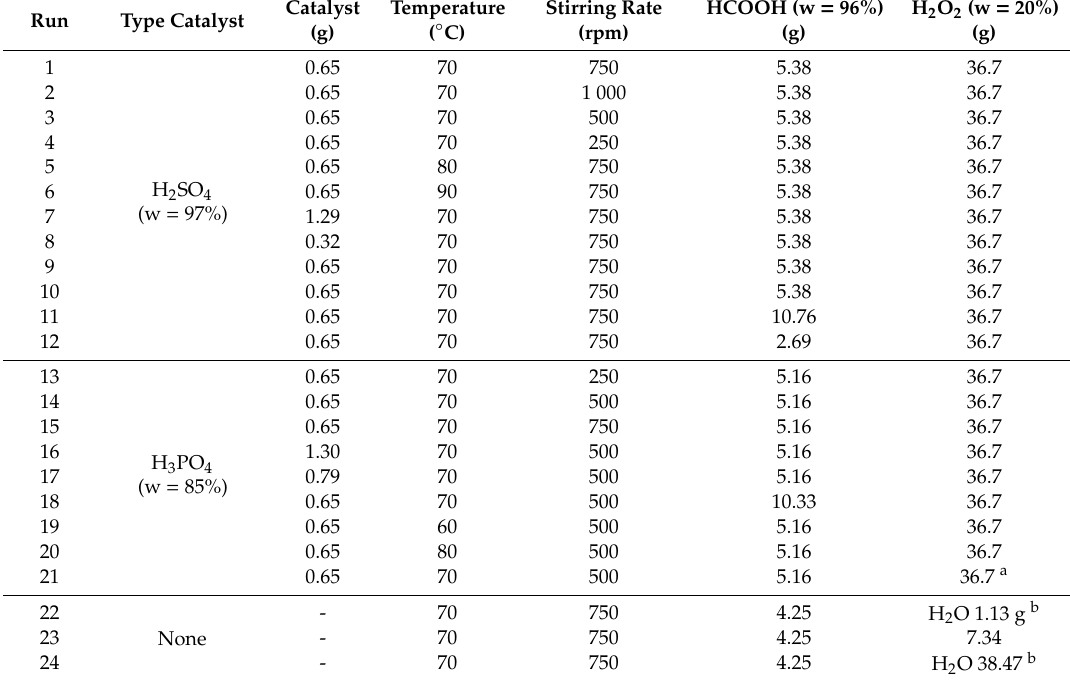
Table 1. List of ring opening experimental runs performed. 100 g of ESBO was used for all the runs. rpm = number of stirrer revolutions per minute. w = mass fraction